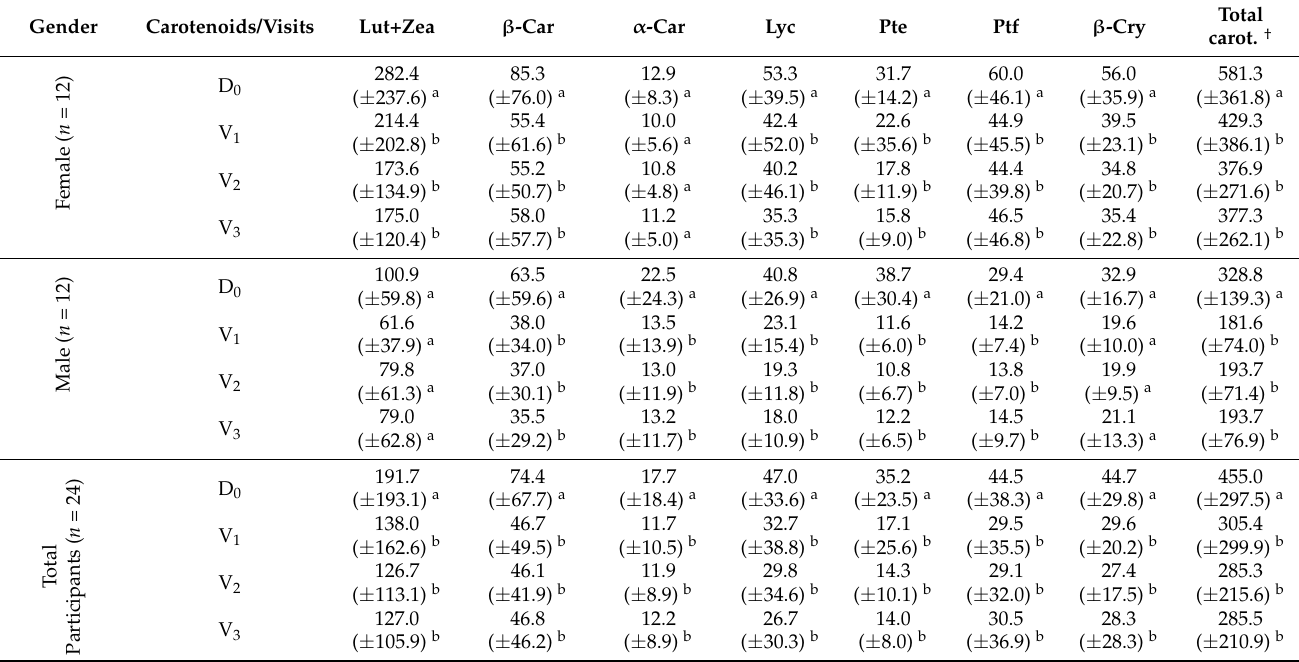
* Each value represents the mean of n ≥ 3 replicates. Lut+Zea: lutein+zeaxanthin; β -Cry: β -cryptoxanthin; Ptf: phytofluene; Pte: phytoene; α -Car: α -carotene; β -Car: β -carotene; Lyc: lycopene. Values in the same column of the same group with a different superscript letter differ significantly. † sum of all listed